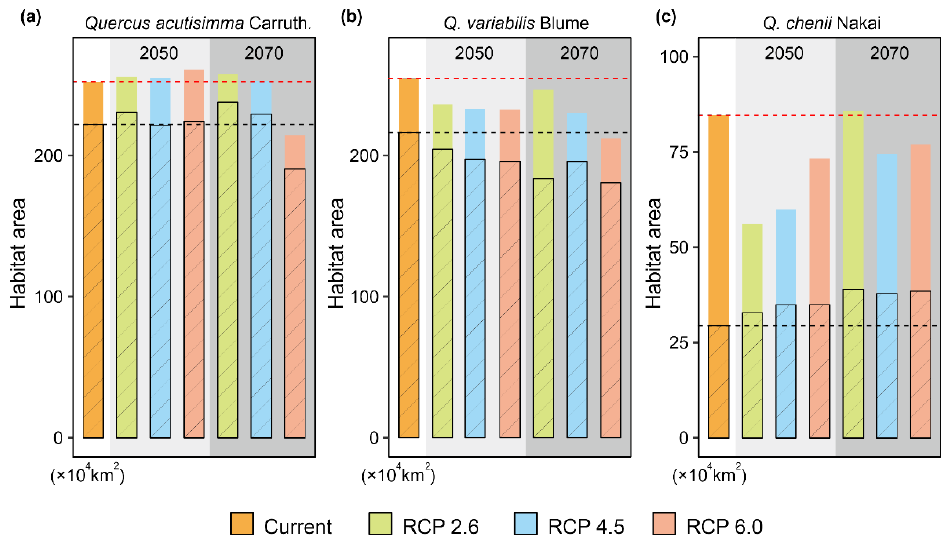
Figure 5. Changes of suitable habitat areas for Quercus acutissima Carruth. ( a ), Q. variabilis Blume ( b ), and Q. chenii Nakai ( c ) in China from the present to the years 2050 and 2070 under three representative concentration pathways (RCPs), i.e., RCP 2.6, RCP 4.5, and RCP 6.0. The habitat areas were estimated based on the results of species distributions models (SDMs) considering climate change (CC), land use and land cover change (LULC) and dispersal limitations. The solid and open histograms represent the suitable habitat areas under the full migration (FM, i.e., migration unlimited) and partial migration (PM, 500 m/year) scenarios, respectively. Red and black dashed lines represent the present suitable habitat areas under FM and PM scenarios, respectively. The species-specific maximum training sensitivity plus specificity (MTSS) thresholds were used to classify the suitable habitats (>MTSS) and unsuitable habitats (<MTSS). Table 1. Changes of core areas (CAs) for Quercus acutissima Carruth., Q. variabilis Blume, and Q. chenii Nakai in China predicted by species distributions models (SDMs) considering both climate change (CC) and land use and land cover change (LULC). Three representative concentration pathways (RCPs) were considered, including RCP 2.6, RCP 4.5, and RCP 6.0, representing different concentration trajectories from eco-friendly (RCP 2.6) to bad case (RCP